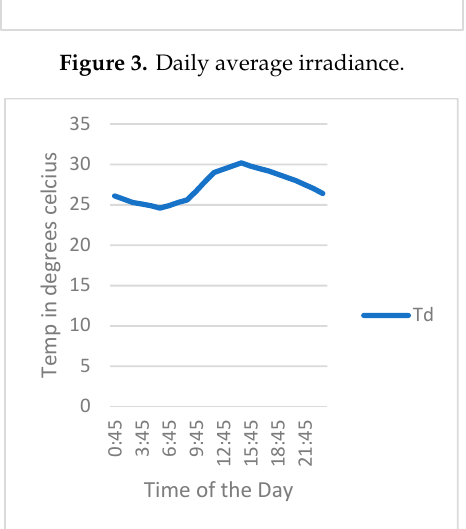
Figure 3. Daily average irradiance.